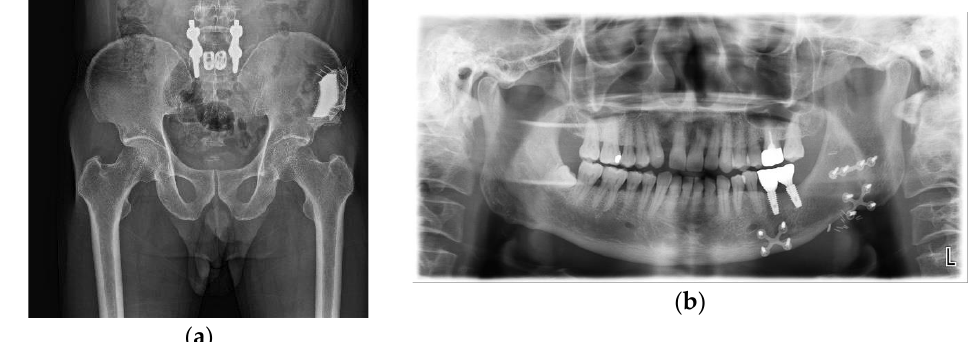
Figure 9. Postoperative radiograph after 1 year: ( a ) patient-specific implant shown on right iliac bone after 1 year; ( b ) well-reconstructed mandible and implants were installed 1 year after the op- eration.